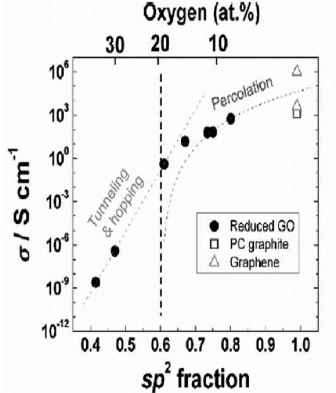
Figure 13. Observing the conductivity of doping in GO. Conductivity of thermally reduced GO acting like sp 2 carbon division. The dashed line in the vertical direction shows the percolation threshold of